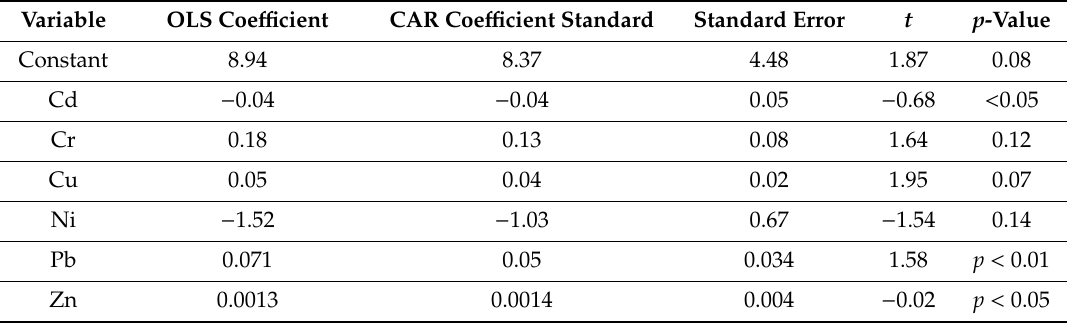
Table 5. Results of the autoregressive model according to the equation in the covariance system, being a function of the matrix for adjacent estimated values.